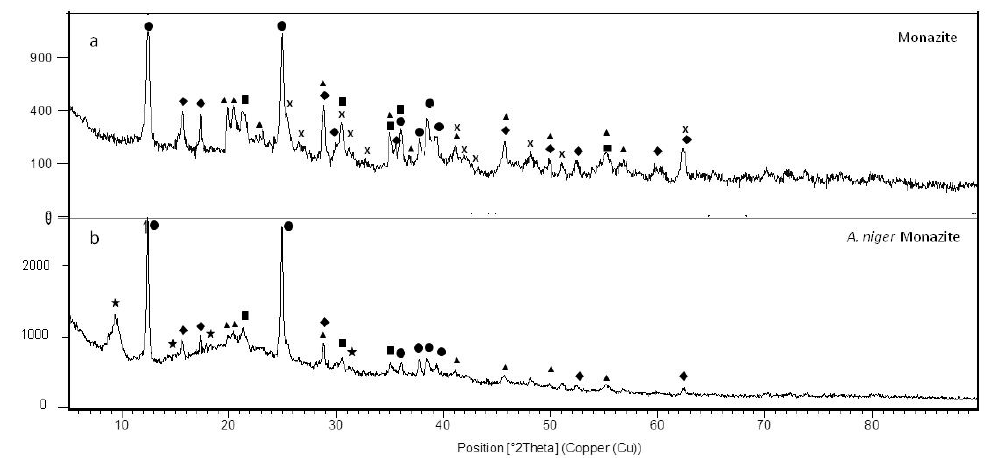
Figure 7. XRD pattern of the monazite ( a ) before and ( b ) after 14 days of bioleaching using A. niger ( ● aluminum silicate hydroxide, ■ silicon oxide, x aluminum cerium phosphate hydroxide, ▲ sodium cerium carbonate fluoride, ♦ potassium hydronium iron sulphate hydroxide, cerium oxalate).